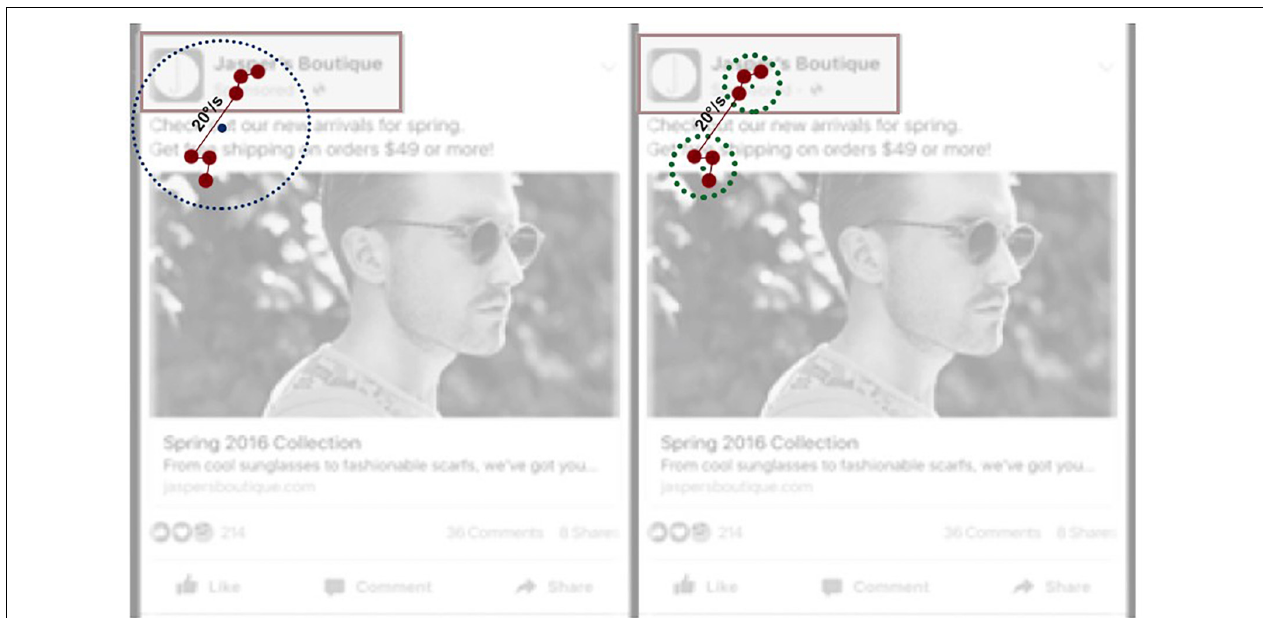
FIGURE 8 | An illustration of the impact of the velocity threshold parameter on the detection and location of fixations on a mock advertisement. On the left side, gaze samples, marked with red dots, are combined into a fixation based on the default threshold value of 30 ◦ /s, and the fixation is located outside the AOI Branding. On the right side, the velocity threshold is lowered to < 20 ◦ /s, resulting in two short fixations with more accurate mean location